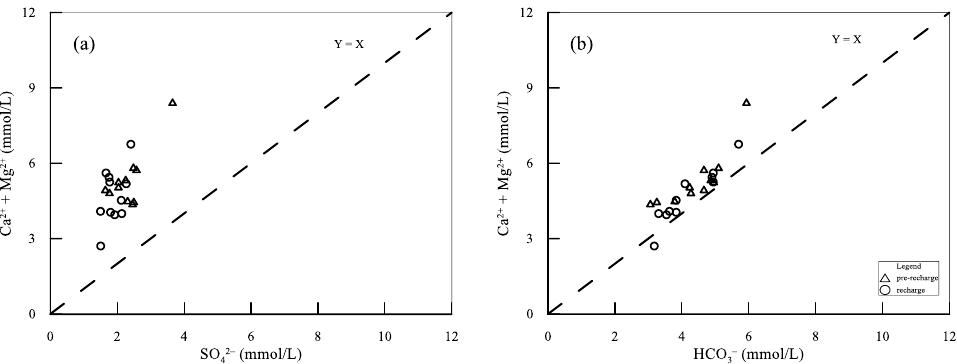
Figure 8. Correlation comparison of (Ca 2+ + Mg 2+ )/HCO 3 − and (Ca 2+ + Mg 2+ )/SO 42 − . ( a ) Relationship between SO 42 − and (Ca 2+ + Mg 2+ ). ( b ) Relationship between HCO 3 − and (Ca 2+ + Mg 2+ ).